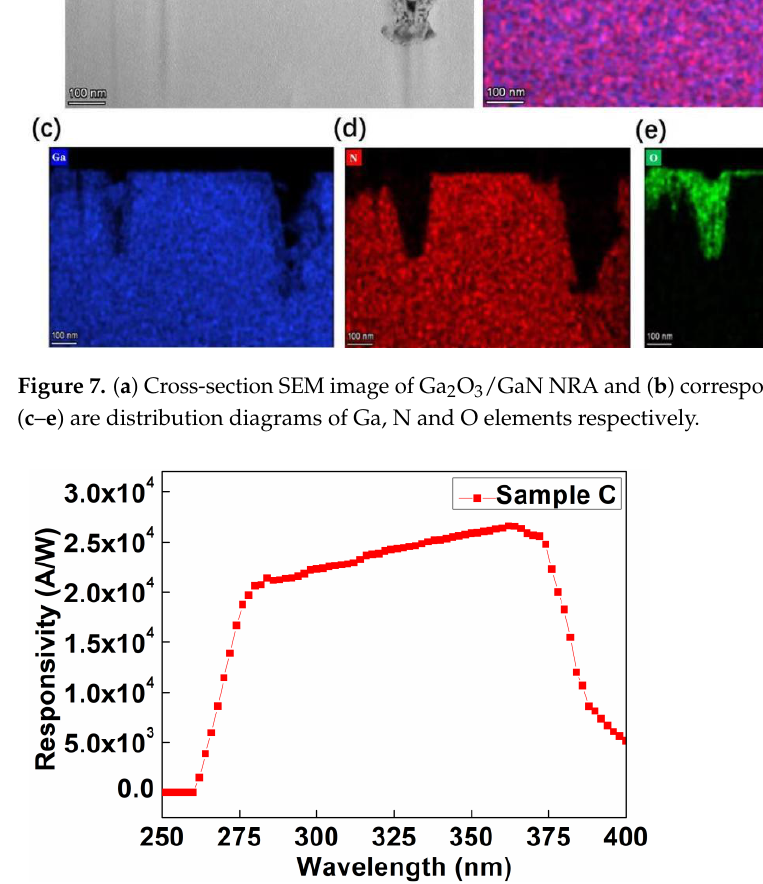
Figure 8. Spectral responsivity values of sample C as a function of wavelength at 7 V bias.